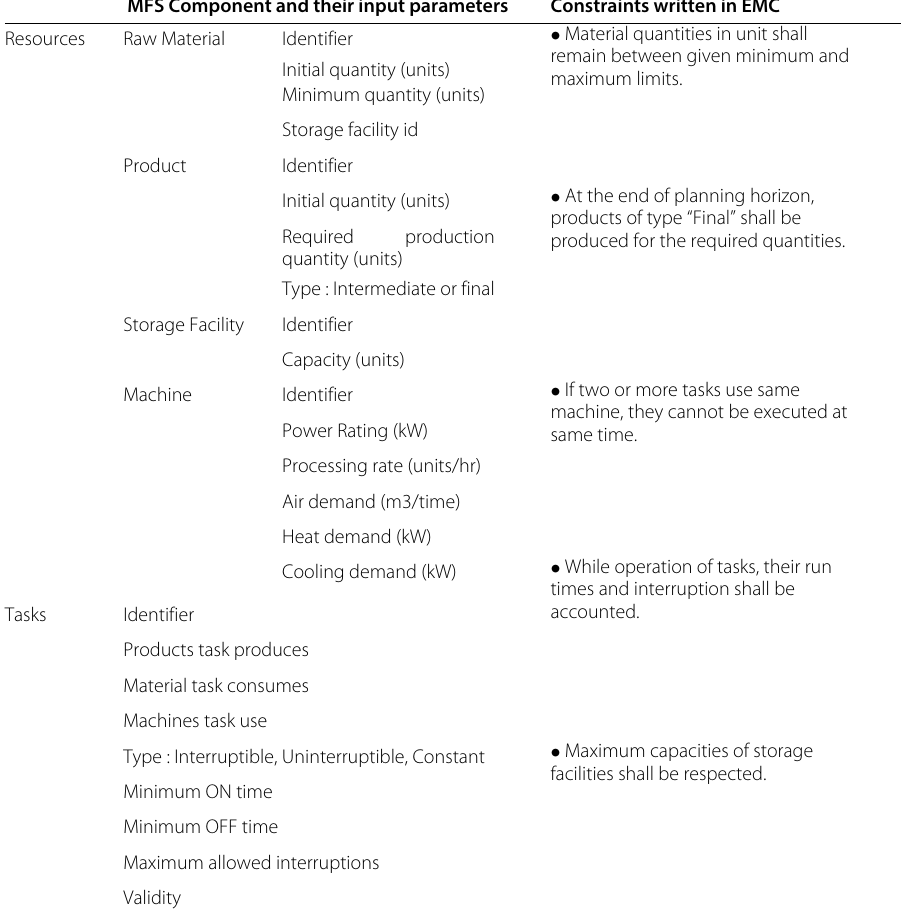
Table 1 Modeling parameters and constraints for MFS in the model